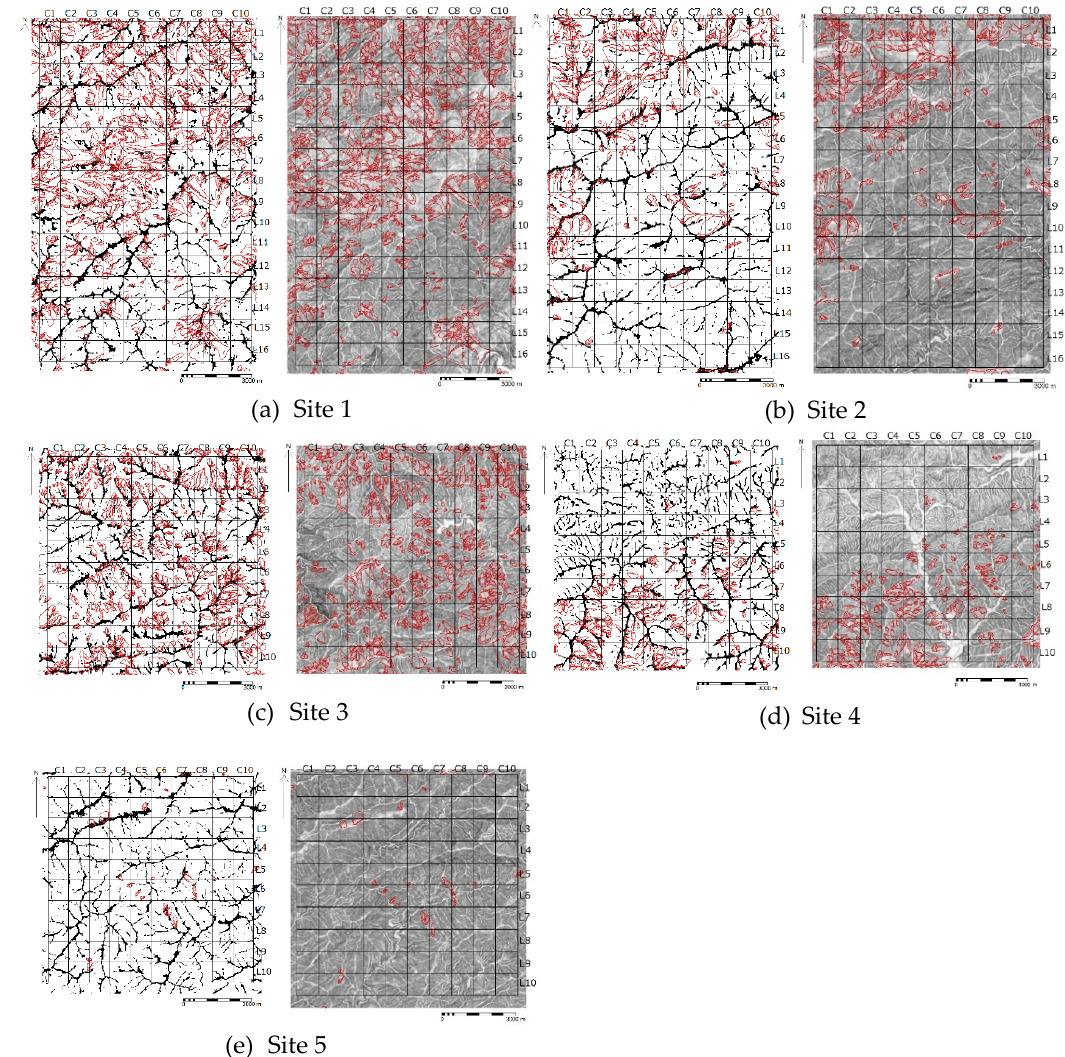
Figure 5. Extracted ridgelines with openness values (left) and the topographic data (right) with landslide inventory (brown lines) in ( a ) Site 1, ( b ) Site 2, ( c ) Site 3, ( d ) Site 4, ( e ) Site 5. Black lines show the 900 m × 900 m grids. Each grid is identified by column ID and line ID.